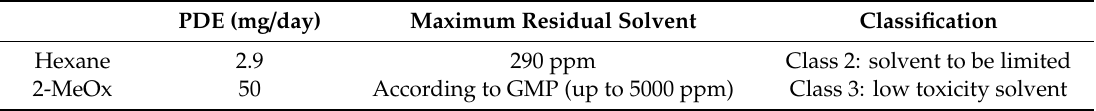
Table 8. Hexane versus 2-MeOx in the International Council for Harmonization (ICH) Q3(R8) draft.